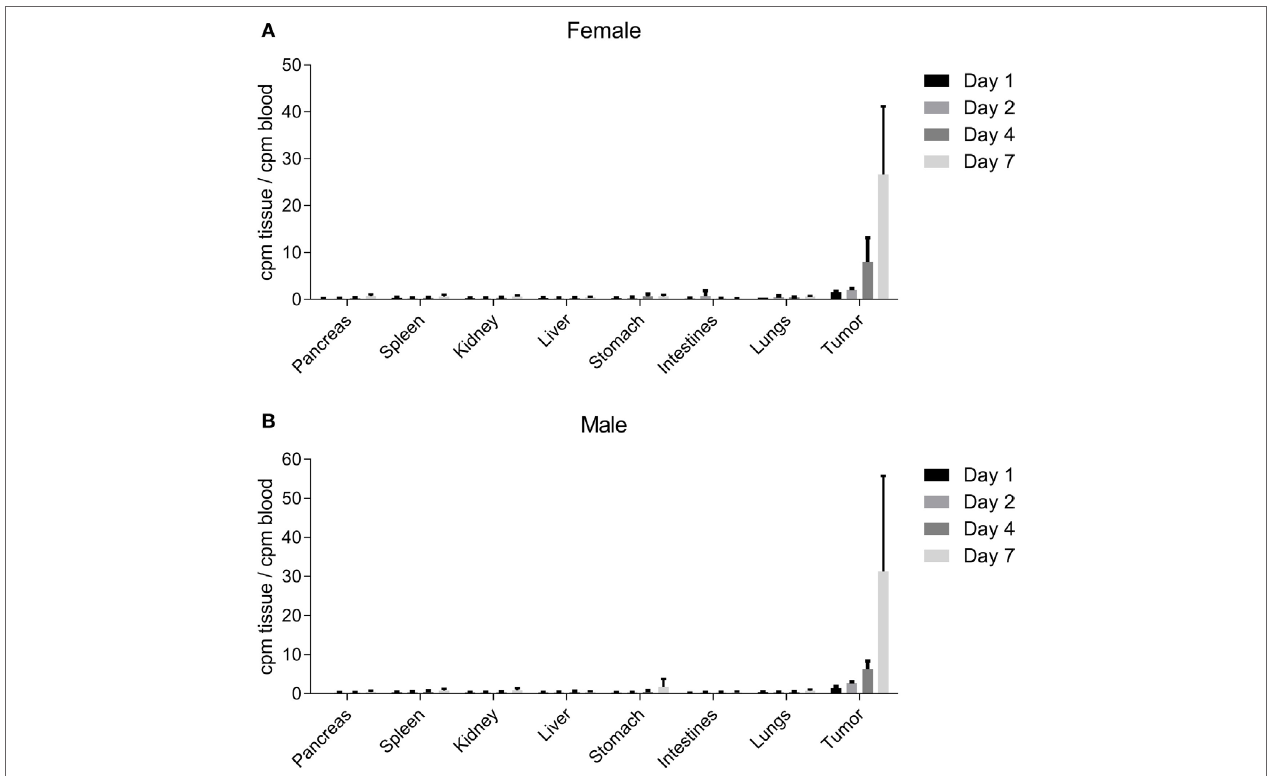
FigUre 5 | NEO-201 biodistribution in CFPAC-1 xenograft-bearing mice. Measurement of normalized radioactivity from the indicated tissues of CFPAC-1 tumor-bearing female (a) and male (B) mice dosed intravenously with radiolabeled NEO-201. n = 4 animals/time point. Days 1, 2, 4, and 7 represent the amount of time between radiolabeled antibody injection and